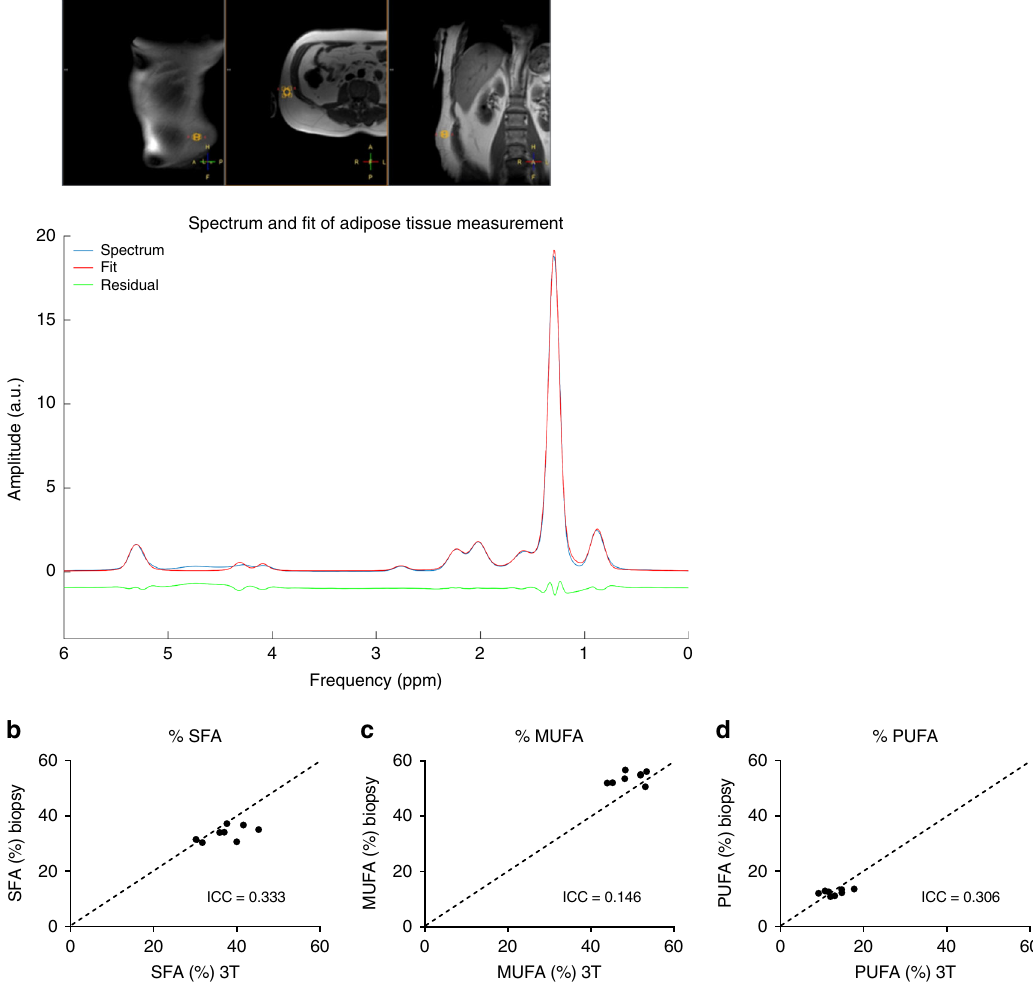
Fig. 2 Validation of 1 H-MRS method in subcutaneous adipose tissue. a T2 weighted Turbo spin echo MR image showing the voxel position located on adipose tissue and its corresponding lipid spectrum together with the fi tted spectrum. The relationships between subcutaneous adipose tissue measured at 3T and adipose lipid composition determined through biopsy for the different lipid fractions: b SFA, c MUFA, and d PUFA ( n = 8). The intraclass correlation coef fi cient (ICC) is shown in the respective plots (Intraclass